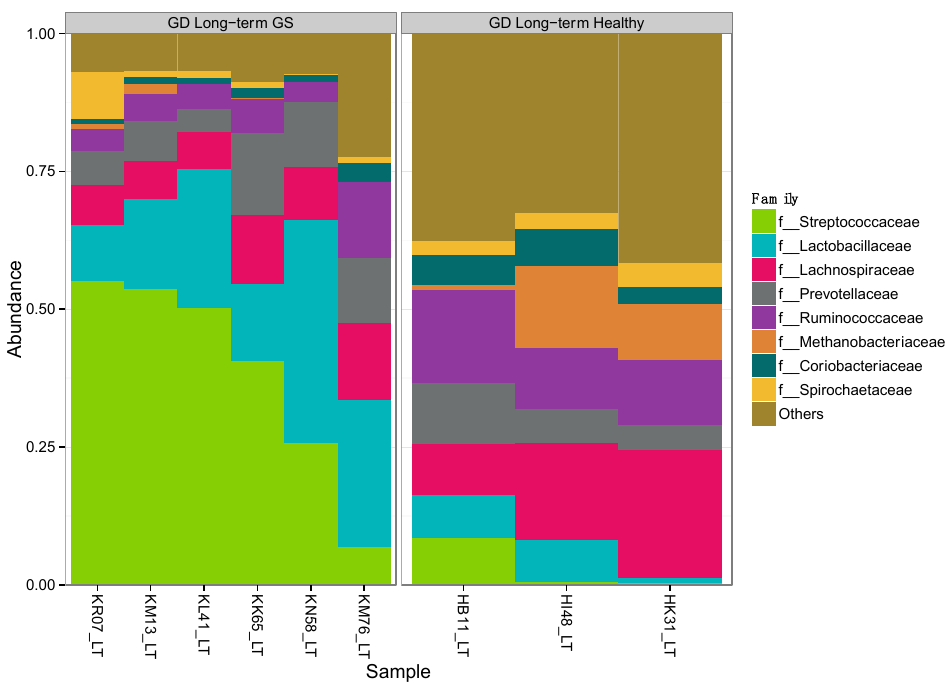
Figure 2. Proportional abundance of microbial taxa in GS and control macaques. Plot shows the most abundant taxa at the family level. Left panel represents GS juvenile macaques on GD diet while right panel indicates age ‐ and diet ‐ matched healthy control macaques.